Question: Condense the content of this figure into a single sentence.
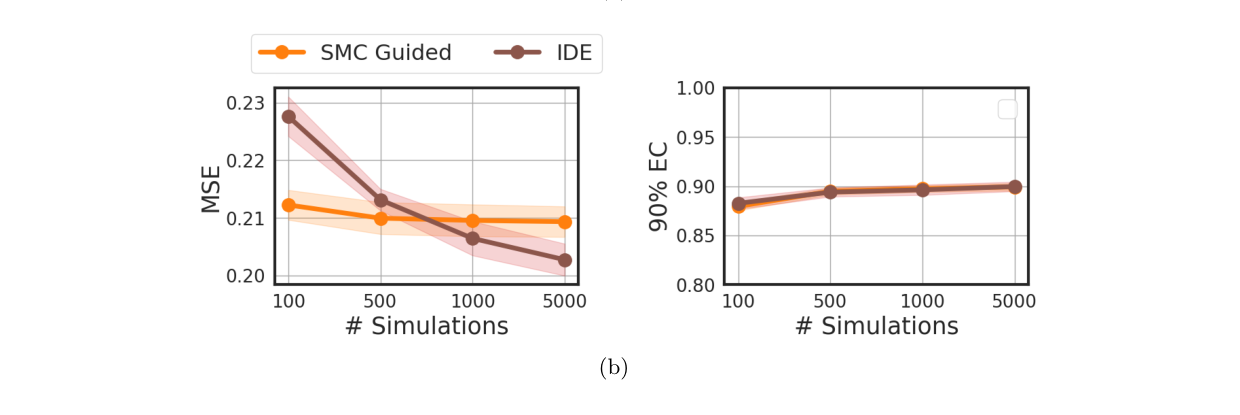
Answer: Estimation of the hidden states of a nonlinear state-space model, for two different experiments: (a) σx = σy = 1 and K = 10, (b) σx = σy = 1 and K = 30. The quality of approximations was quantified using the MSE and 90% EC, summarised using the mean (solid line) and 95% confidence intervals (shaded area), across 10 datasets.